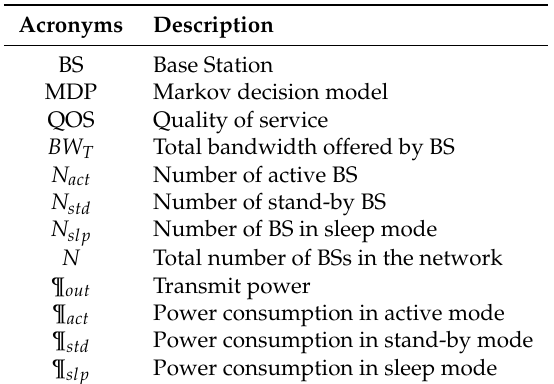
Table 1. The acronyms and